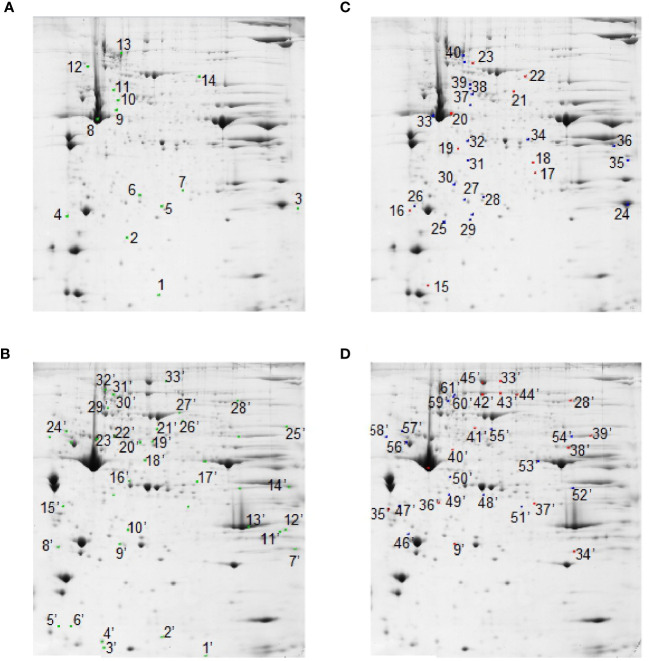
2D-E based quantitative analysis of skeletal muscle proteomes. Representative 2D-E Coomassie Blue stained maps of total soluble proteins from tibialis anterior (A, C) and soleus (B, D). 2D-E was performed using a nonlinear pH range of 3–10 in the first dimension (17 cm strips) and SDS-PAGE (12% T) in the second dimension. Protein loading was 650 µg/gel. Green crosses show differentially represented spots (p<0.05-at least 2-fold change) in the SS vs. CSS comparison in tibialis anterior (A) and soleus (B). Red crosses show differentially represented spots (p<0.05-at least 2-fold change) in the comparison RF vs. SS in tibialis anterior (C) and soleus (D). Blue crosses show differentially represented spots (p<0.05-at least 2-fold change) in the RF vs. CRF comparison in tibialis anterior (C) and soleus (D). Statistical significance in pair-wise comparisons was evaluated by Student’s t-test.